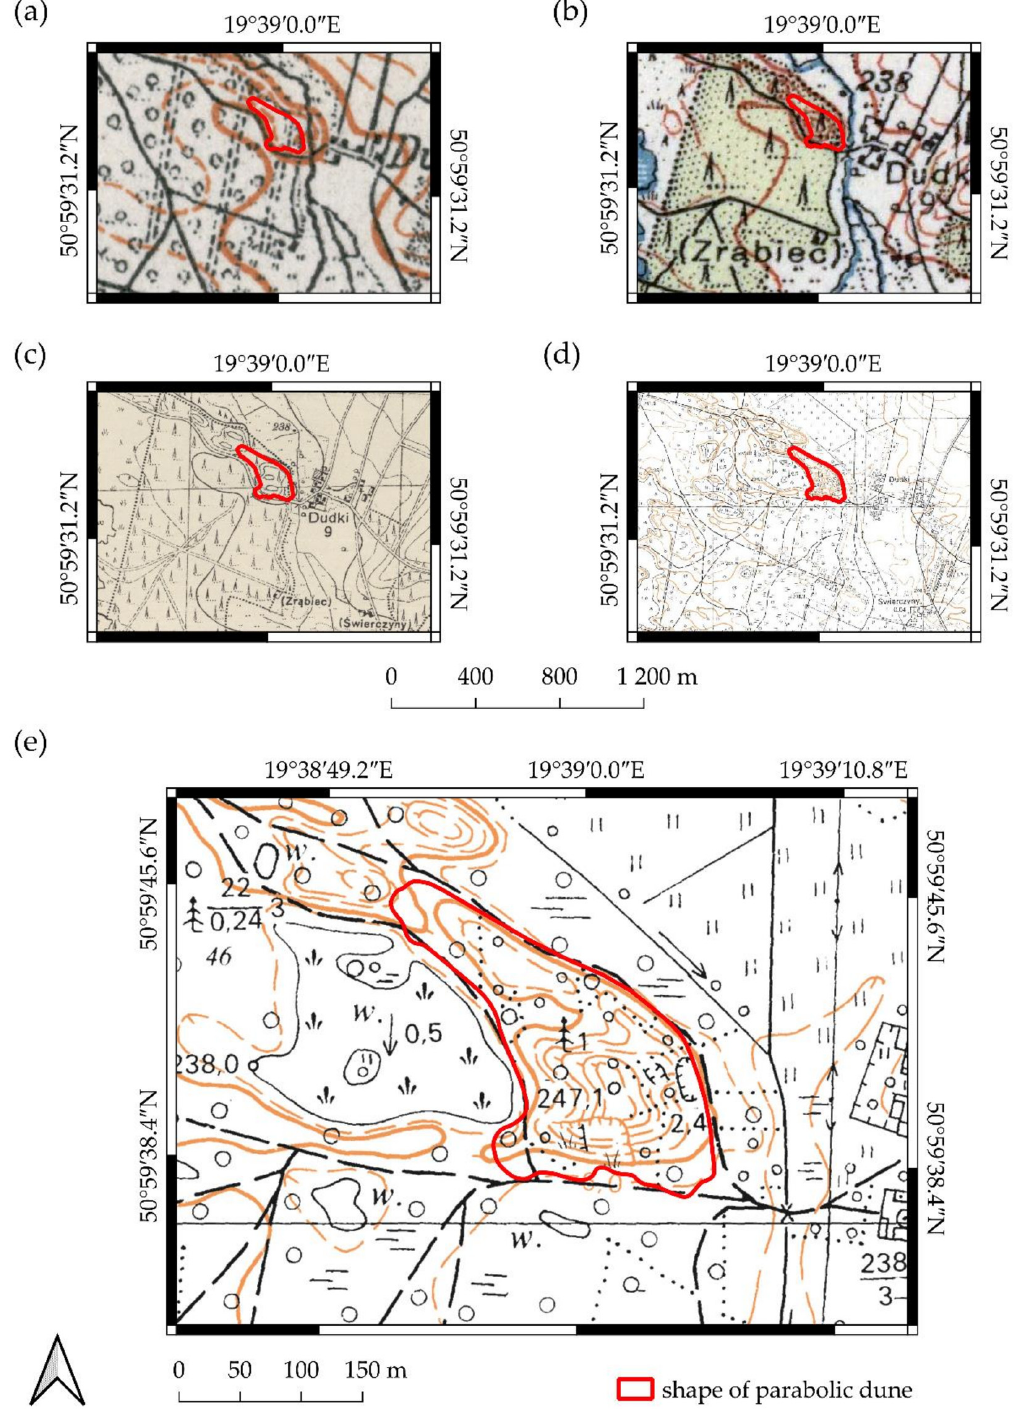
Figure 3. Cartographic materials displaying the parabolic dune and its surroundings areas: ( a ) part of the Tactical Map of Poland with scale of 1:100,000 from the year 1926 [53]; ( b ) part of the Tactical Map of Poland with scale of 1:100,000 from the year 1935 [54]; ( c ) Tactical Map of Poland with scale of 1:25,000 from the year 1937 [55]; ( d , e ) part of the Topographic Map of Poland with a scale of 1:10,000 from the year 1986